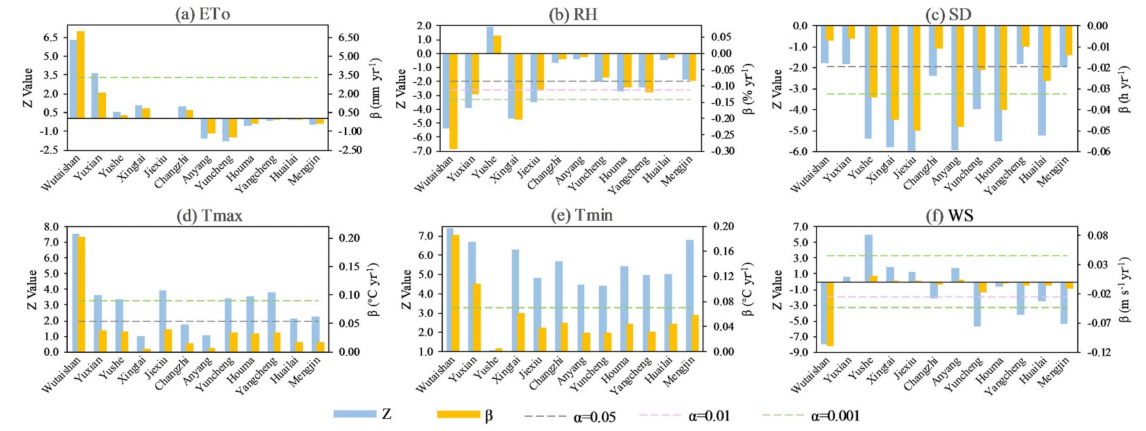
Figure 4. Z values and change rates ( β ) of climatic factors at 12 meteorological stations and the whole THM during 1973–2016: ( a ) ETo; ( b ) RH;( c ) SD; ( d ) Tmax; ( e ) Tmin; ( f )